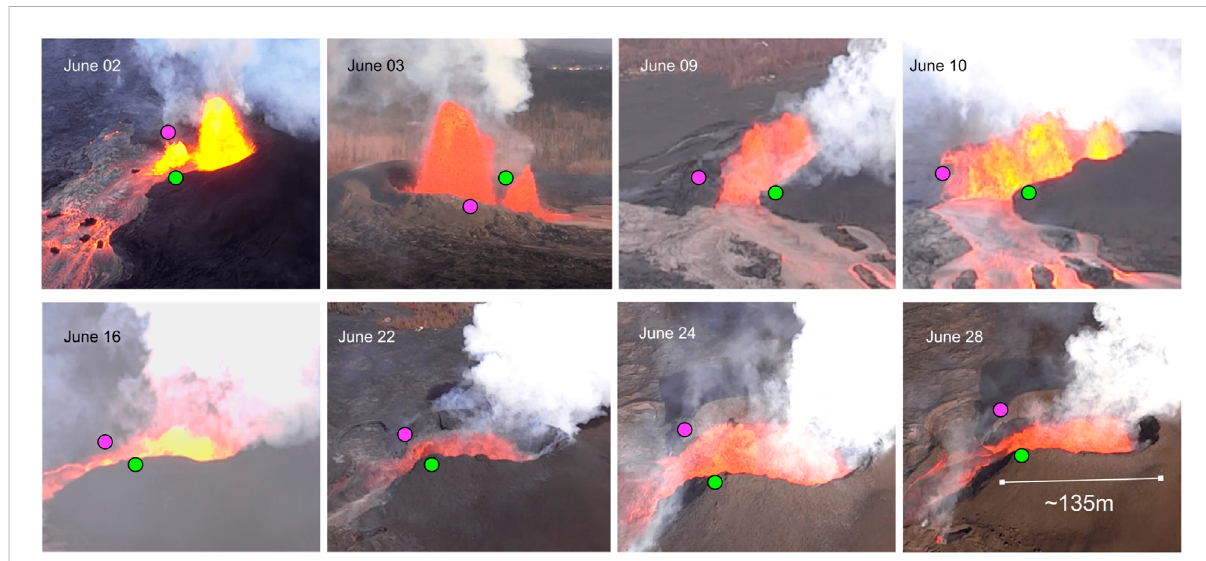
FIGURE 2 SingleframesofUASvideosofthelabeleddays.Theseframesshowrepresentativeactivityobservedintherespectivevideos.Notethattheseare taken from different view angles, distances and local times. The green and pink circles are reference points on each side of the spillway for easier orientation. A representative scale for the length of the fi ssure is shown on the photo of June 28.